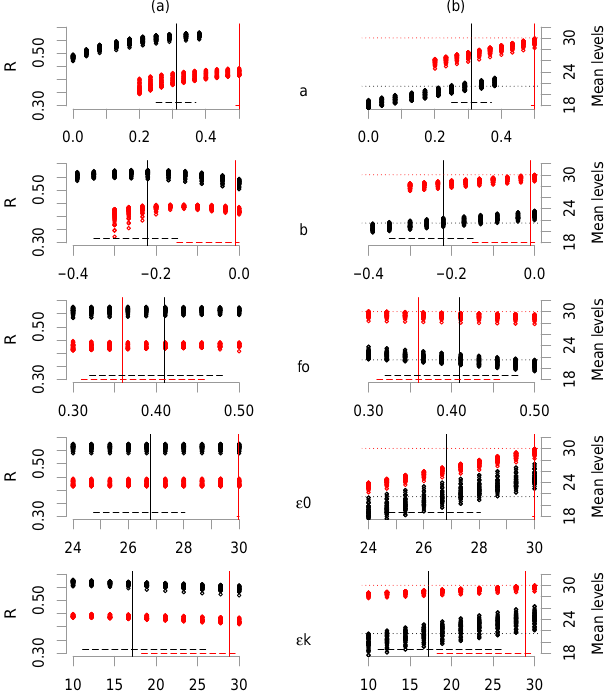
Figure 2. Dependence of the correlation coefficients between ob- served and simulated δ 18 O TR series (a) and of the mean simulated δ 18 O TR levels (‰) (b) as a function of the range of calibrated pa- rameters a , b , f o , ε 0 and ε k for the 50 simulations performed. The tests sites from Québec are in black and the Argentinean ones are in red. The vertical lines are the values of a plausible block of param- eters retained in the MCMC optimization. The horizontal dashed lines are their respective 90% confidence interval calculated with 50 simulations (see Table 1). The horizontal dot lines in (b) are the mean values of the observed δ 18 O TR .